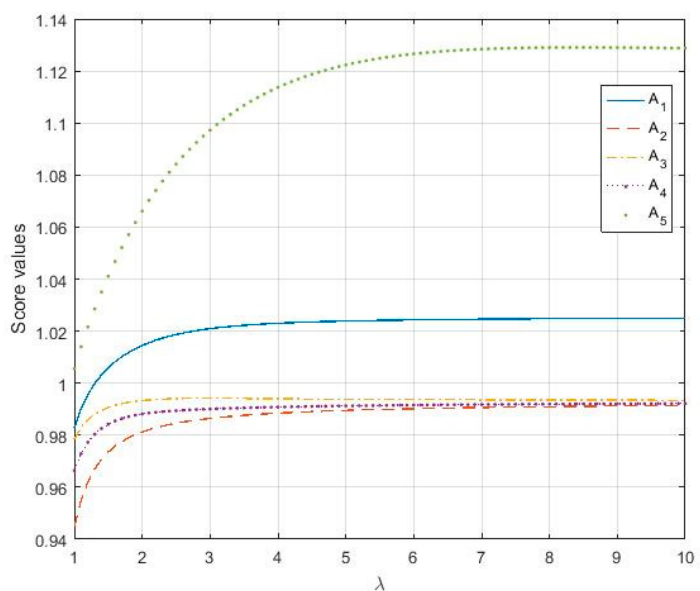
λ ∈ ( 1,10 ) based on the q -RPFDWDHM ( ) λ∈ 1,10 based on the q- RPFDWDHM operator. Figure 4. Score values of the alternatives when